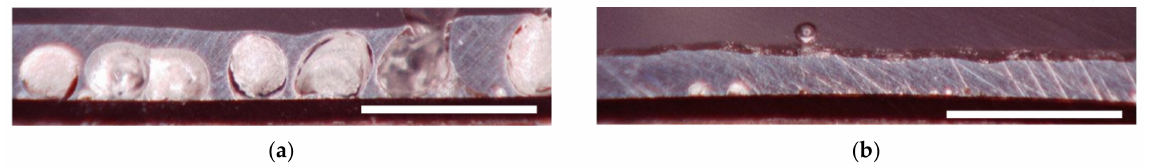
Figure 13. Longitudinal cross-section of tracks printed on substrate at ( a ) 25 ◦ C ( b ) 150 ◦ C. Scale bar = 1000 µ